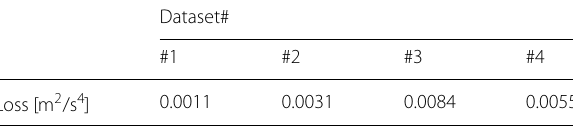
Table 3 Loss of Regression w/ L2 normalization after 200 epochs